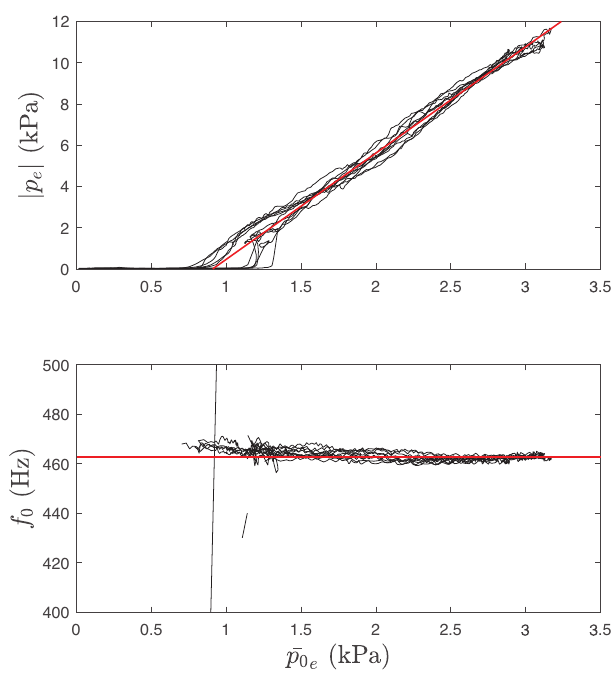
Figure 8. Experimental bifurcation diagrams obtained from one player playing a Bb4 with slow crescendo-decrescendo (same data as in Fig. 7). Top: | p e | with respect to (cid:2) p 0 . The top red line is obtained by averaging the respect to (cid:2) p 0 e linear regression coef fi cients of each diagram for (cid:2) p 0 The bottom red line is obtained by averaging f 0 values for (cid:2) p > 1 : 5 0 e